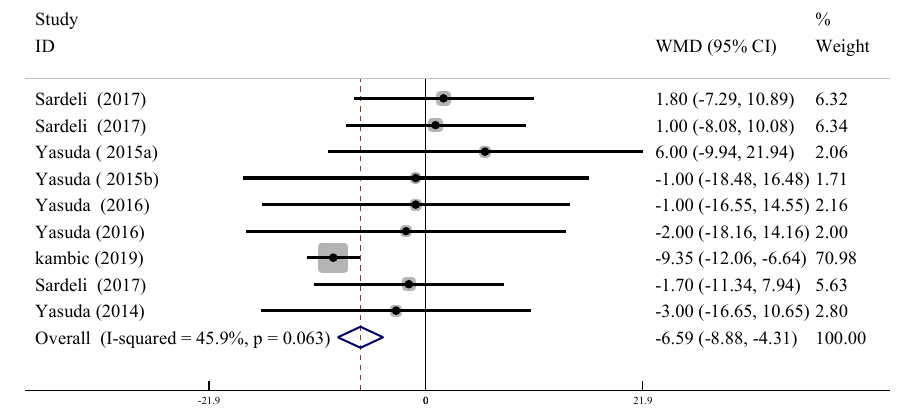
Overall (I-squared = 45.9%, p =